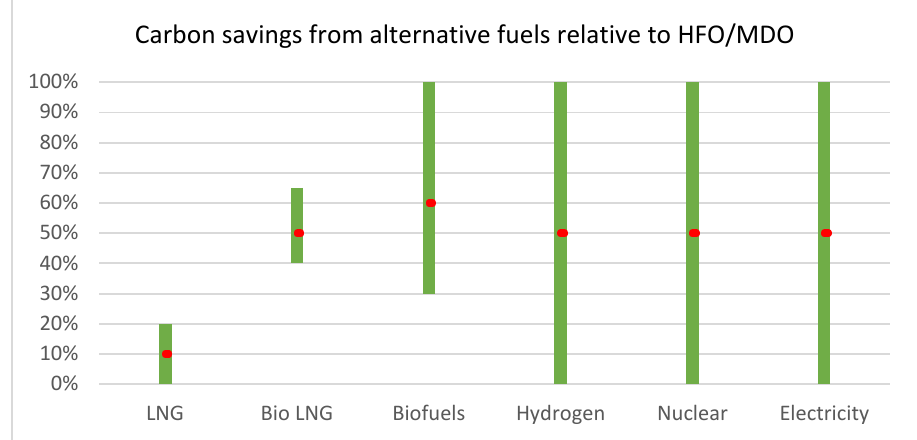
Figure 19. Amounts of GHG emissions that can be reduced by using alternative fuels according to [15,18,189].